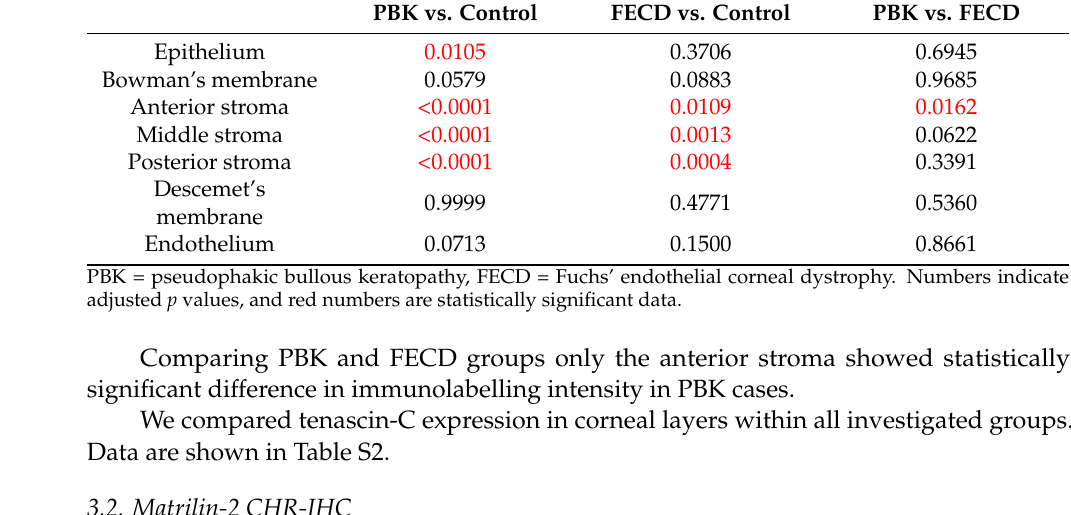
Table 5. Matrilin-2 immunopositivity in the different corneal layers in normal and pathologic conditions. Epithelium Bowman’s membrane Anterior stroma